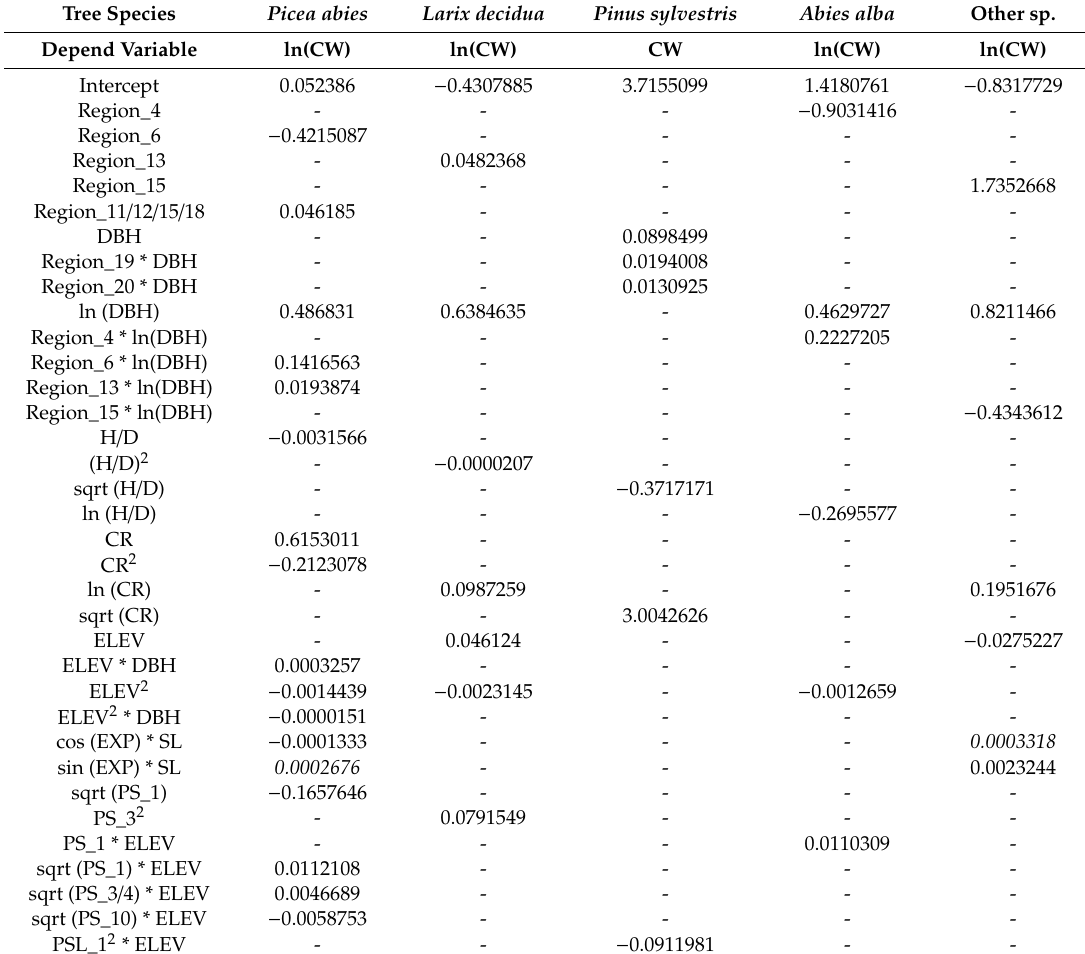
Table 3. Parameter estimates of the mixed-e ff ects crown width (CW)-models for conifer species. The dependent variable CW and diameter at breast height (DBH) of the CW-model for Scots pine were not transformed. All shown estimates were significant ( p -values < 0.05), except values printed in italics.